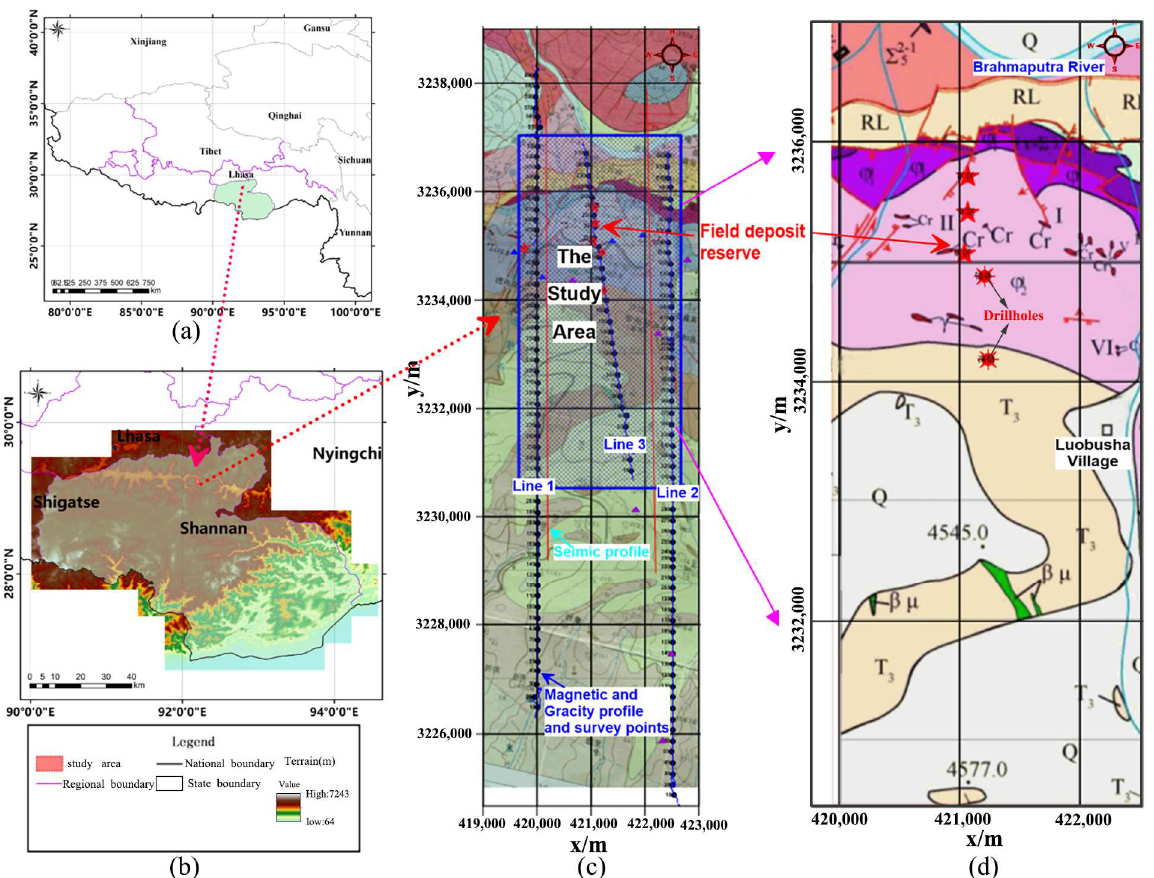
Figure 6. Location map and geological map of the study area. ( a ) Location map of the study area; ( b ) terrain map of the study area; ( c ) gravity and magnetic profile position; ( d ) geological map of the study area.